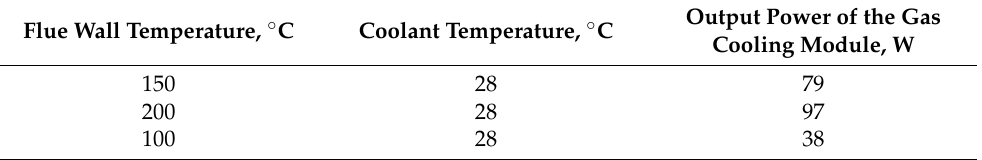
Table 5. Preliminary calculation of the output power of the gas cooling module. Flue Wall Temperature, ◦